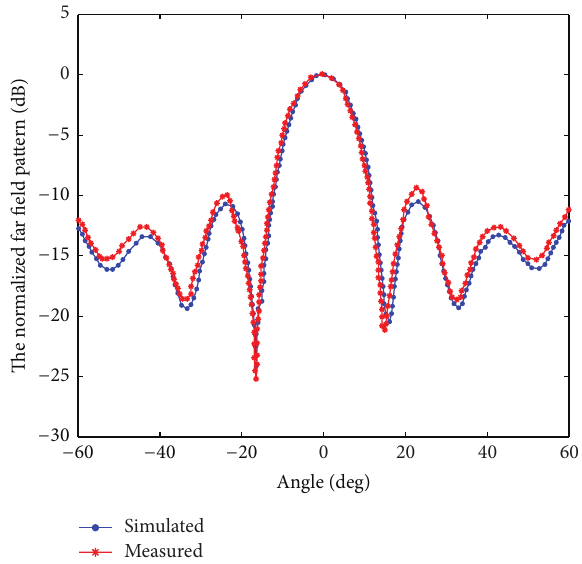
Figure 6: The measured and simulated patterns of CLAS.